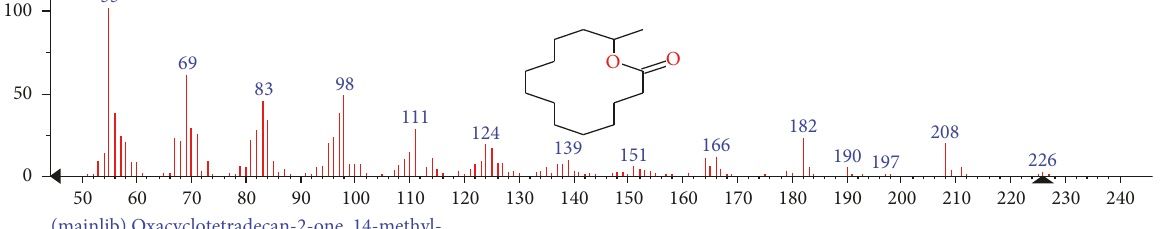
14-methyl-50 60 (mainlib) Oxacyclotetradecan-2-one, Figure 26: Mass spectrum of compound oxacyclotetradecan-2-one, 14-methyl of whole plant hexane fraction of Achillea wilhelmsii (WHFAW).